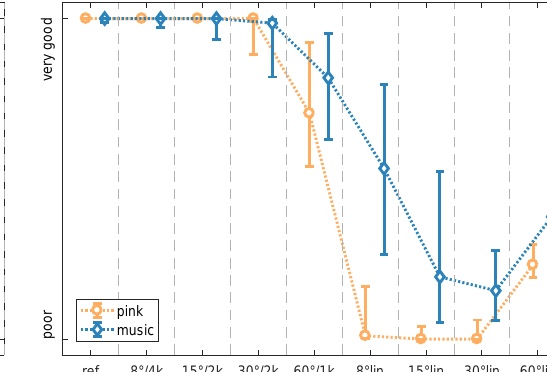
Table 1. p -values (Wilcoxon signed-rank test with Bonferroni–Holm correction) for ratings of timbre and spatial mapping of Experiment I. The upper triangle corresponds to timbre, the lower triangle to spatial mapping. Insignificant differences ( p -values ≥ 0.05) are indicated by bold numbers.